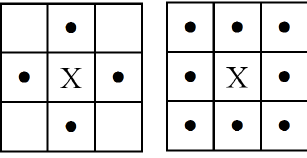
Figure 7. Four-neighborhoods and eight-neighborhoods.